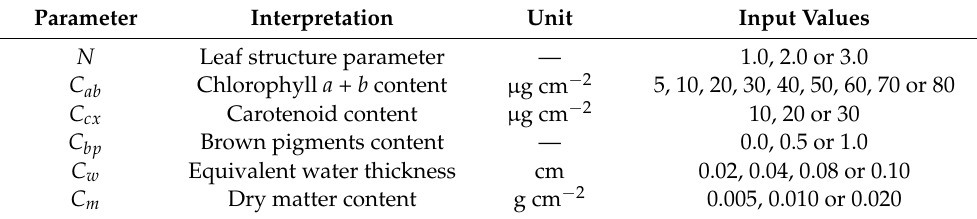
Table 2. The input parameters and corresponding input values of the PROSPECT-5 model.